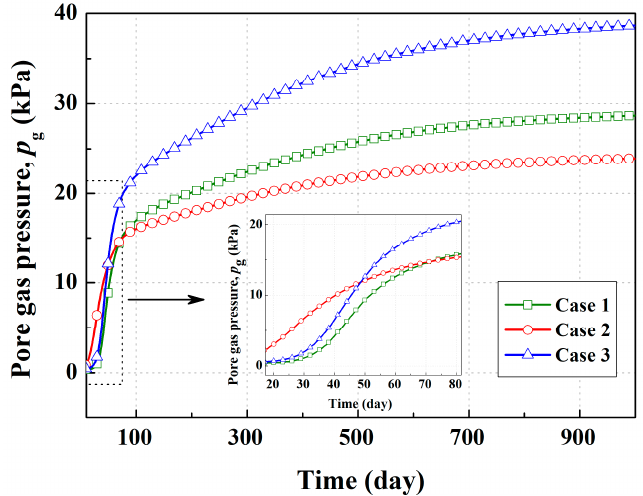
Figure 7. Pore gas pressure at the depth of 8 m in the landfill cell.